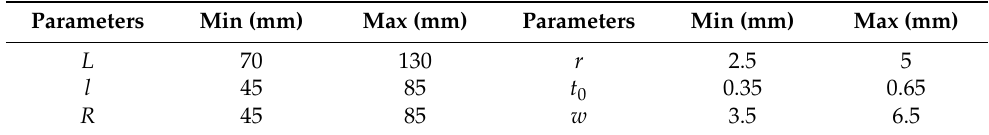
Table 4. Variation range of geometric parameters of